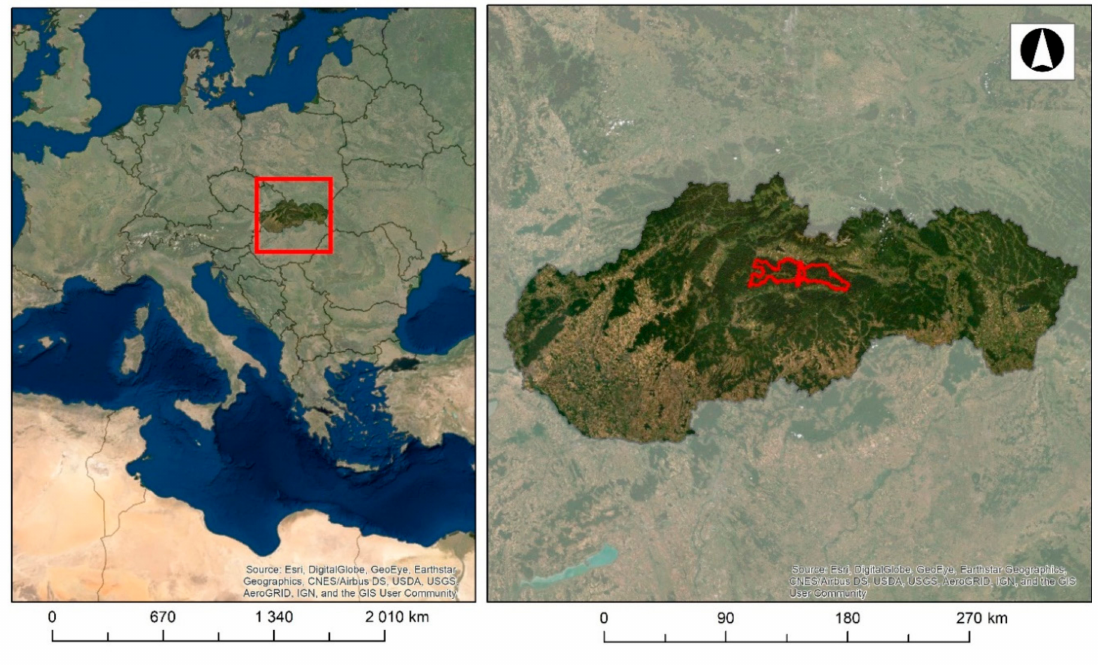
Figure 1. The location and demarcation of Low Tatras National Park in